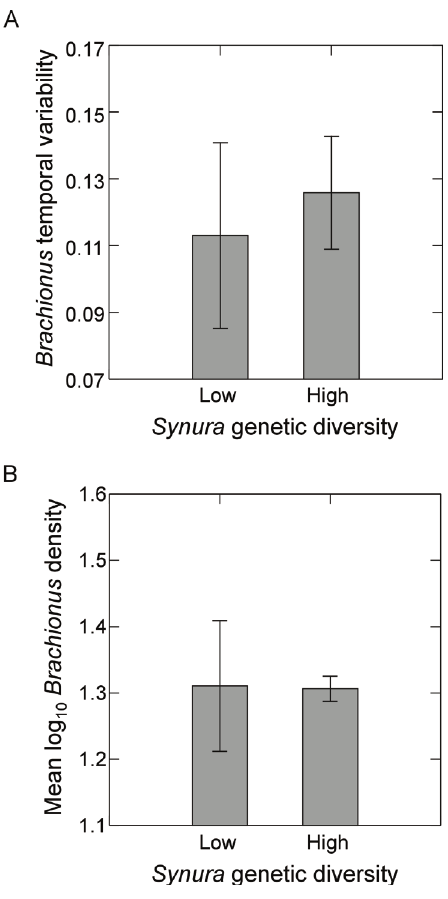
Figure 4. Synura dynamics in presence of Brachionus (closed symbols) or absence of Brachionus (open symbols) for ( A ) populations with low initial Synura genetic diversity or ( B ) populations with high initial Synura genetic diversity. Dynamics for each replicate are shown separately (different symbols). Original units in numbers of individuals per